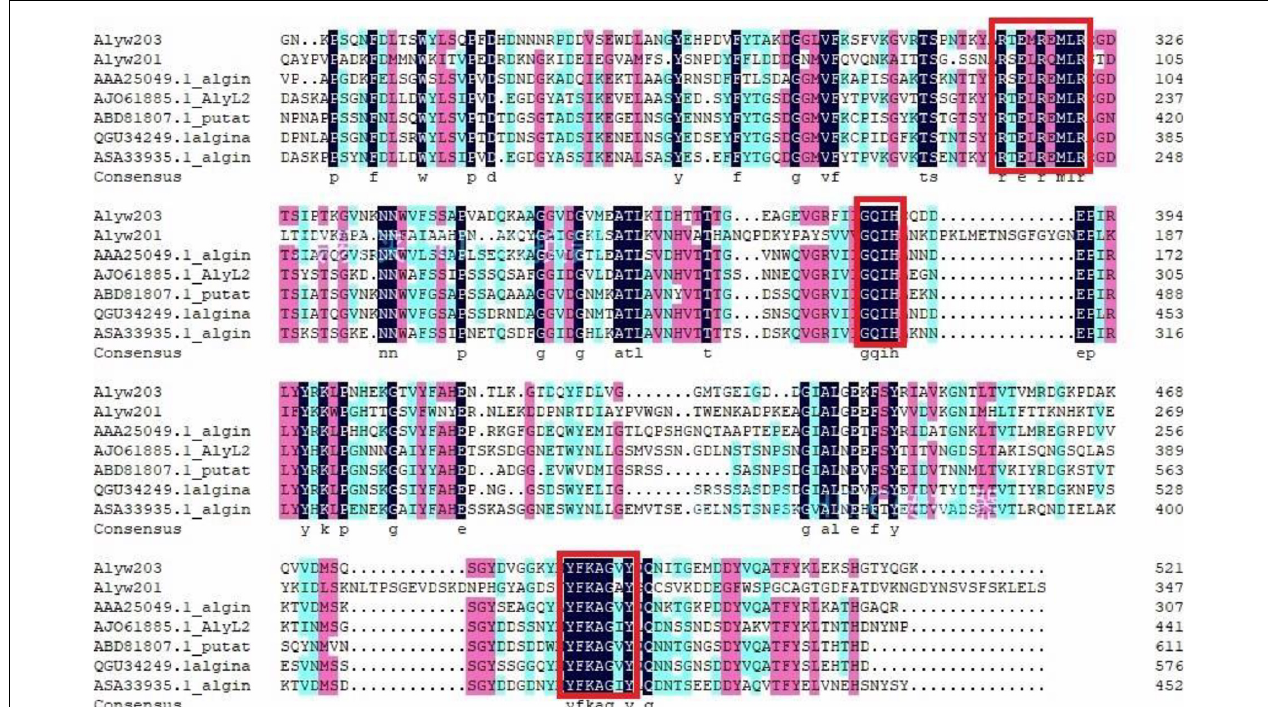
FIGURE 1 | Sequence comparative analysis of Alyw203 with six relevant alginate lyases. The conserved amino acid regions are listed in the red block.